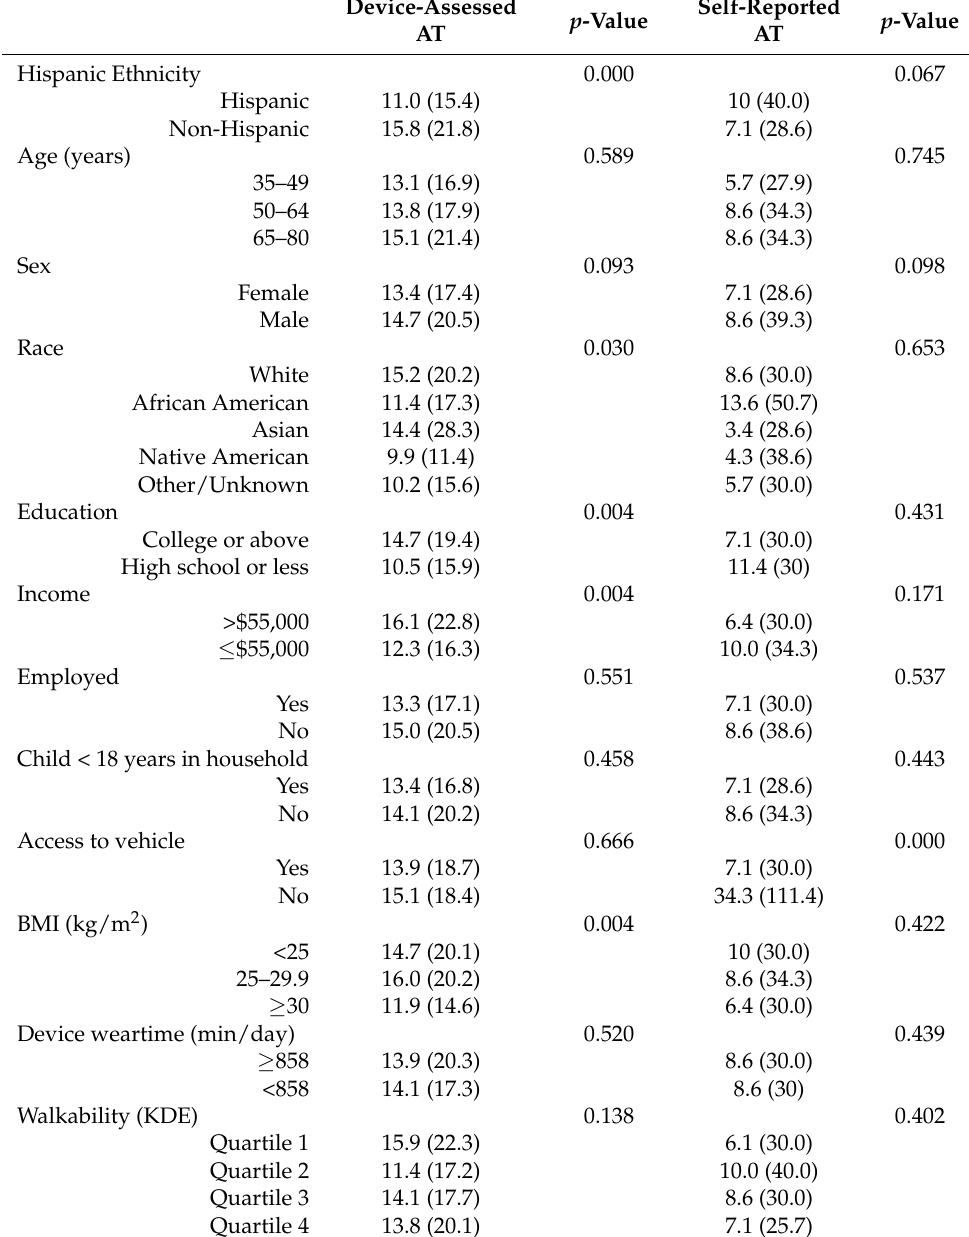
Table 2. Median minutes per day of device-measured and self-reported